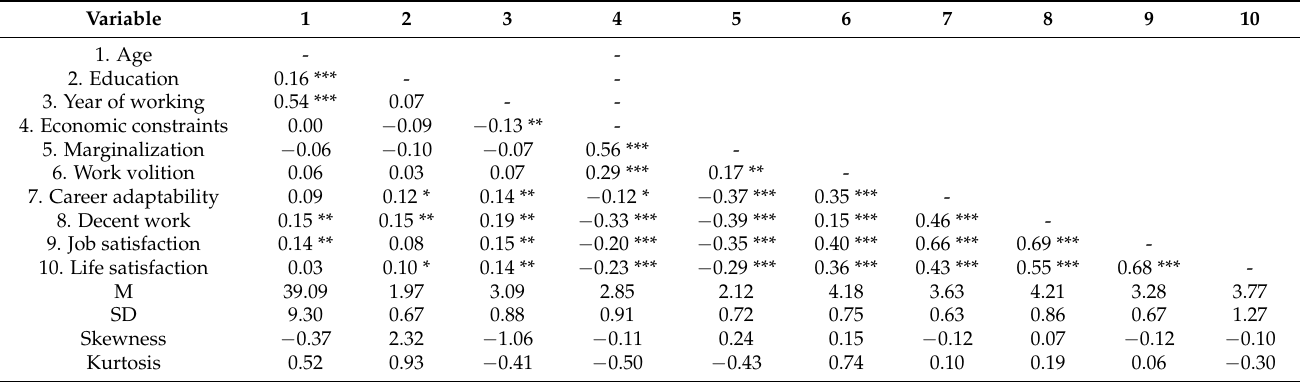
Table 2. Descriptive statistics and bivariate correlations ( N =